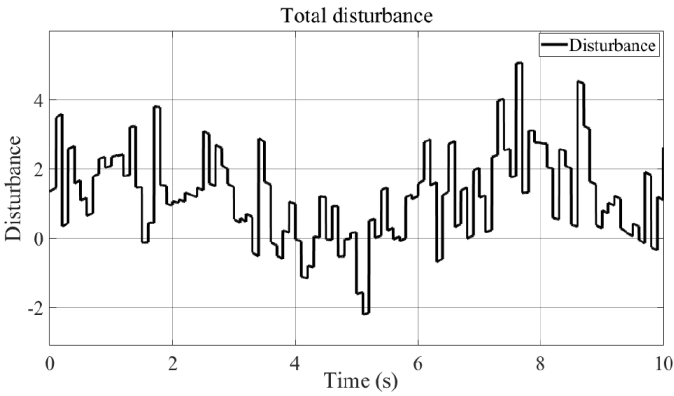
Figure 6. Total disturbance/perturbation. Table 3. Heart model parameter of X.